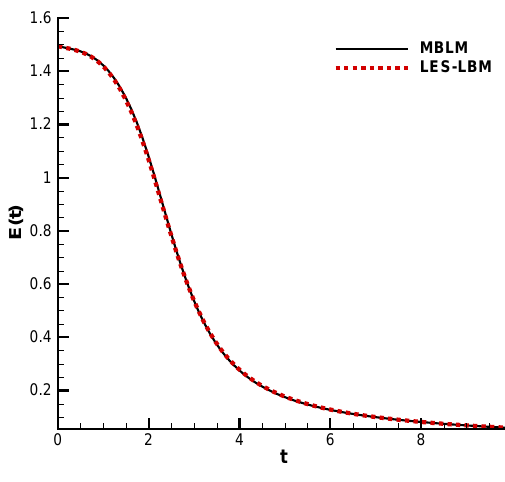
Fig. 7 Comparison of kinetic energy decay at Re λ = 314 on mesh 256 3